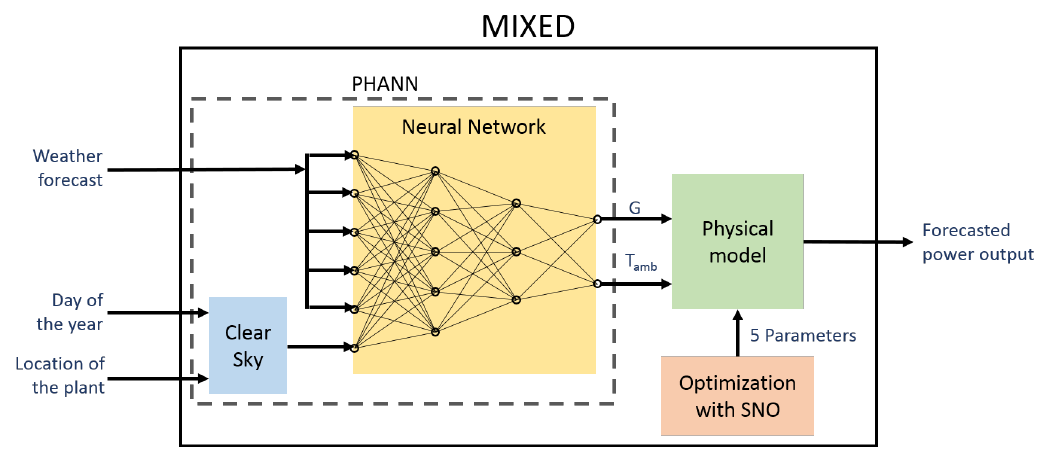
Figure 5. Block diagram of the mixed